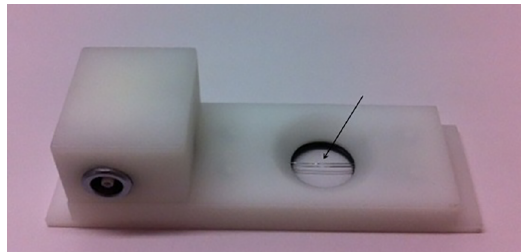
Figure 1. Digital photograph of the cell used for the application of the electric field during the optical fluorescence